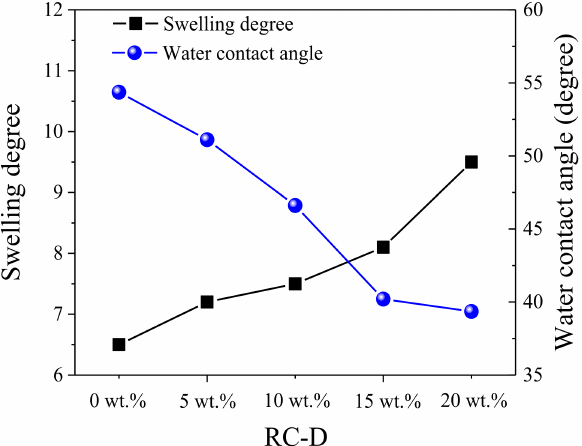
Figure 8. The swelling degrees and water contact angles of polymer-based paint